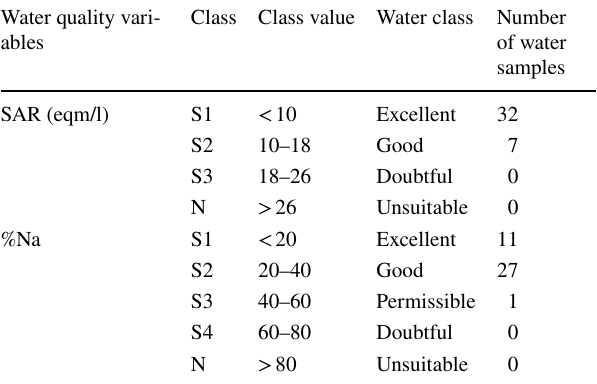
Table 4 Irrigation groundwater quality sodicity hazard classification based on SAR and